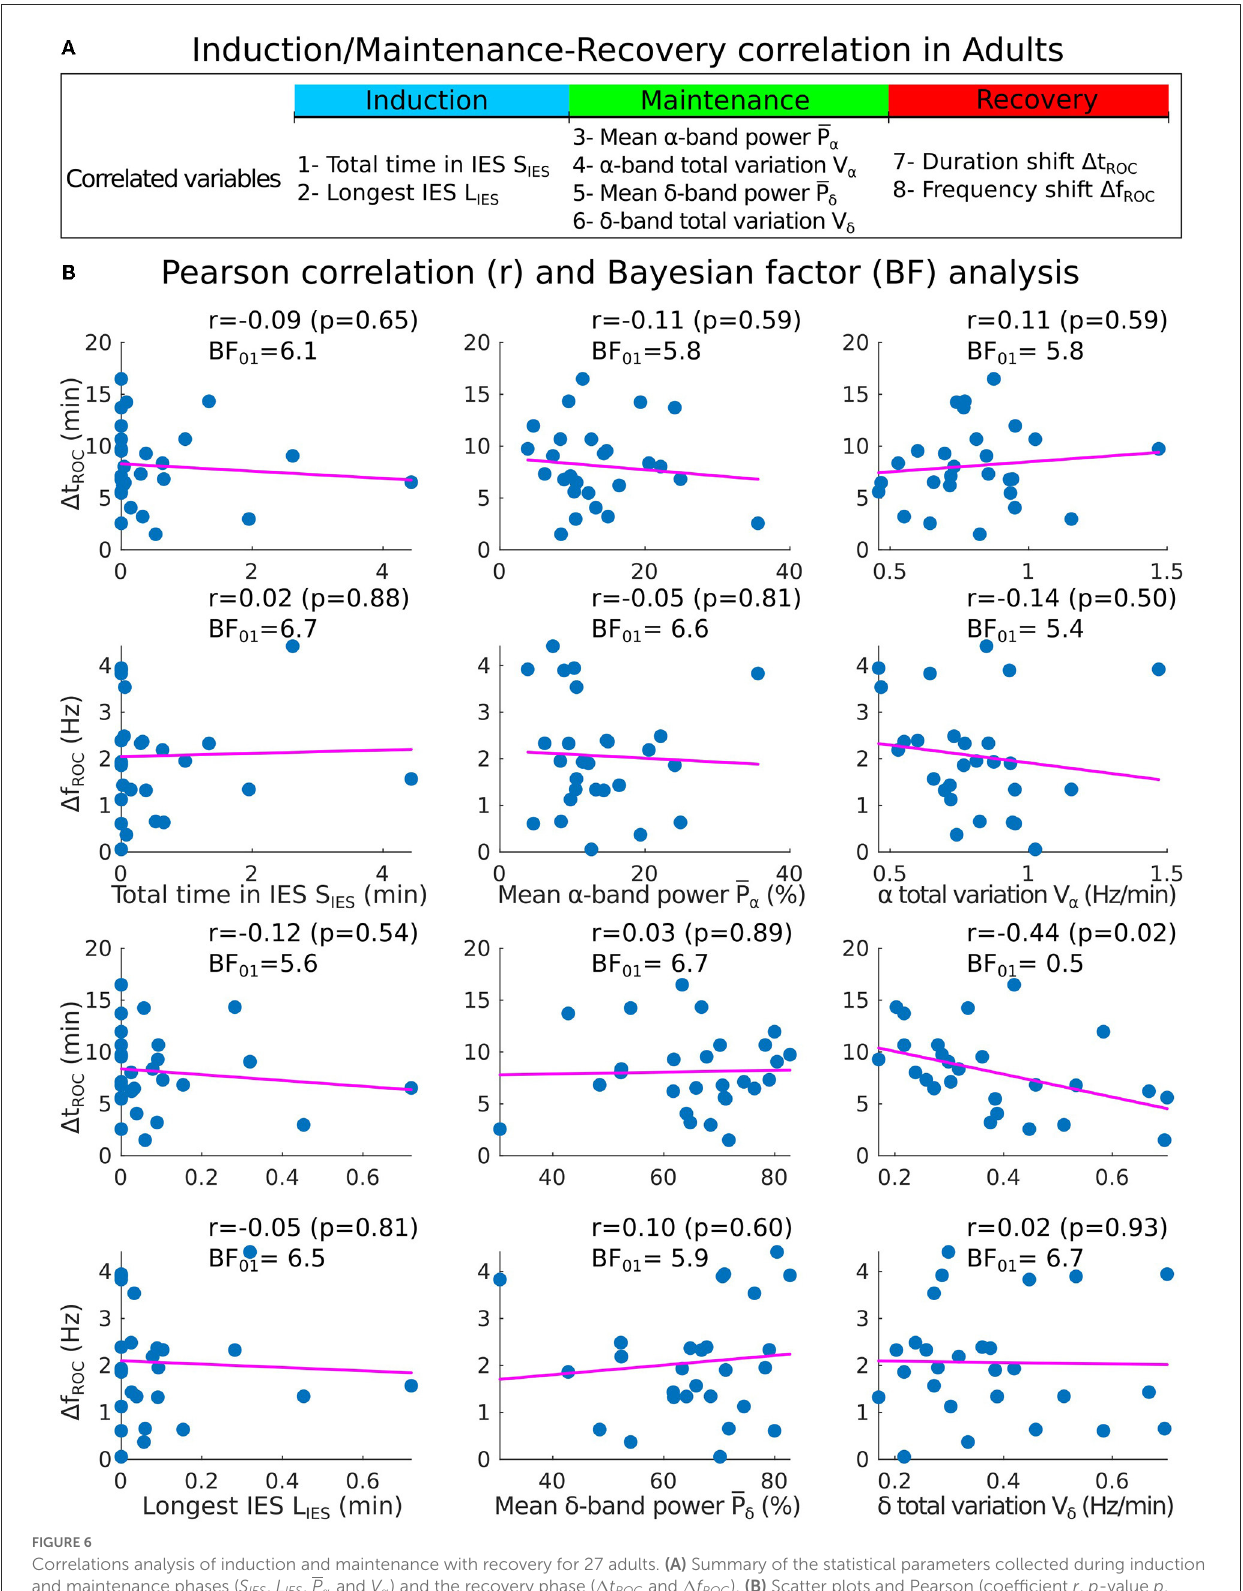
FIGURE6 Correlations analysis of induction and maintenance with recovery for 27 adults. (A) Summary of the statistical parameters collected during induction and maintenance phases ( S IES , L IES , P α and V α ) and the recovery phase ( 1 t ROC and 1 f ROC ). (B) Scatter plots and Pearson (coefficient r , p -value p , Bayes factor BF 01 ) correlations between 1 t ROC ( 1 f ROC ) and S IES , L IES (first column), P α , P α (second column), V α and V δ (third